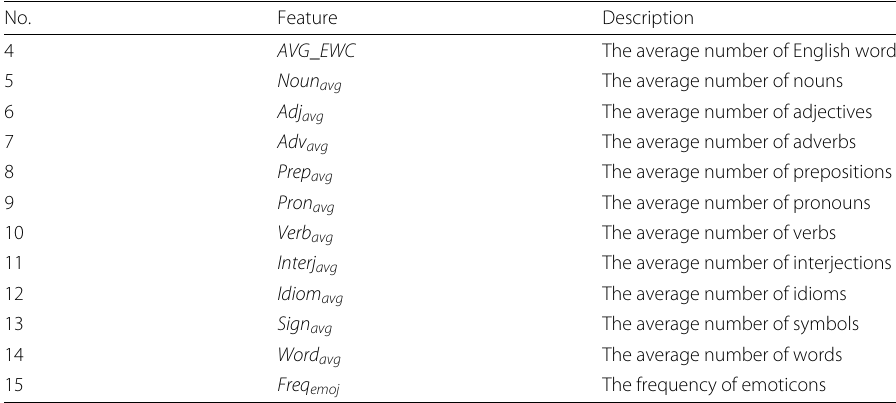
Table 4 Gender-specific thesaurus-based feature